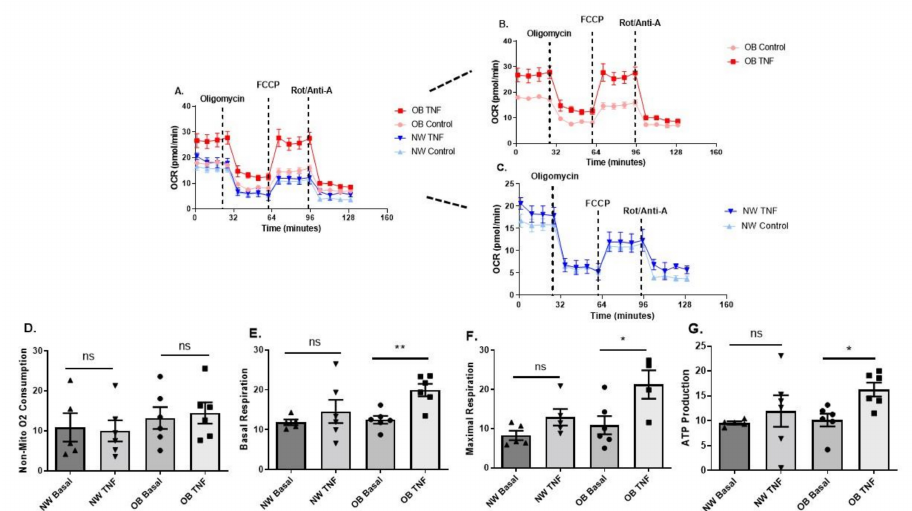
Figure 3. Obese and normal-weight OA synovial fibroblasts exhibit differential mitochondrial respiration. ( A – C ) OA synovial fibroblasts from obese patients (n = 6 patients, with 5 biological replicates per patient) stimulated with TNF α at 10 ng/mL for 24 h show increased mitochondrial respiration, compared to fibroblasts from normal weight patients. ( D ) Non-mitochondrial oxygen consumption does not increase in OA synovial fibroblasts from obese or normal weight patients with TNF α stimulation. ( E ) basal respiration; ( F ) maximal respiration; and ( G ) ATP production from mitochondrial respiration significantly increase in obese OA synovial fibroblasts when stimulated with TNF α at 10 ng/mL for 24 h. All data presented as mean ± SEM. * = p < 0.05, ** = p < 0.01.